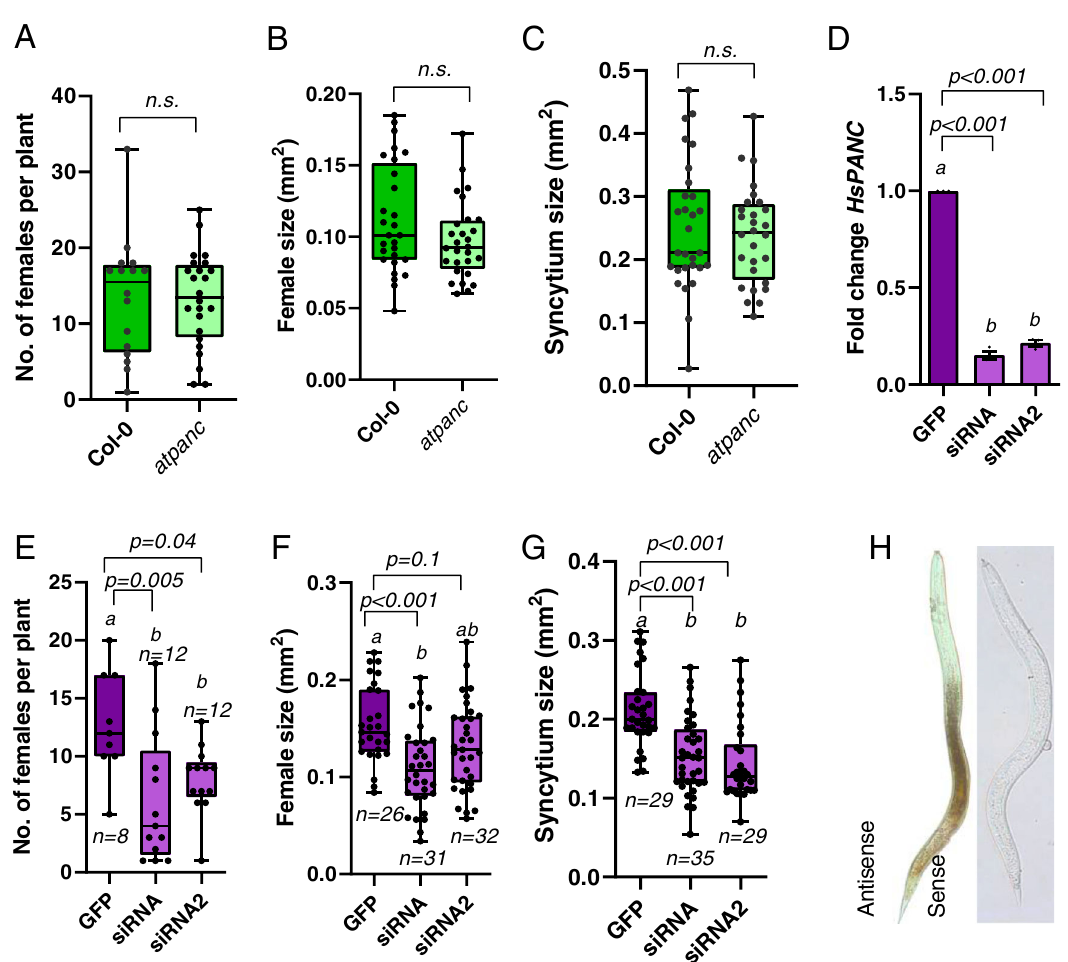
Fig. 9 | Hspanc , but not AtPANC , is required for cyst nematode parasitism. A Numberoffemalecystnematodespresentperplantrootsystemat14dpi(Col-0, n =16; atpanc , n =24). B Sizeofsyncytiaat14 dpi. Female-associatedsyncytiawere randomlyselectedandtheiroutlinesweremeasured(Col-0, n =28; atpanc , n =28). C Size of females at 14 dpi. Female nematodes were randomly selected and their outlines were measured (Col-0, n =28; atpanc , n =28). A – C Experiments were performed three times independently with a similar outcome. Data from one experiment is shown. Source data are provided as a source data fi le. Data were analysedusing Student ’ s t test (two-sided; α =0.05).No signi fi cant difference(n.s.) was detected. D Change in transcript abundance of HsPANC gene in J2 nematodes soaked in siRNA targeting HsPANC or GFP. Bars represent mean±SE. Data were analysed using a one-way analysis of variance (ANOVA) followed by Tukey ’ s HSD post hoc test ( α =0.05) and different letters indicate signi fi cantly different means.